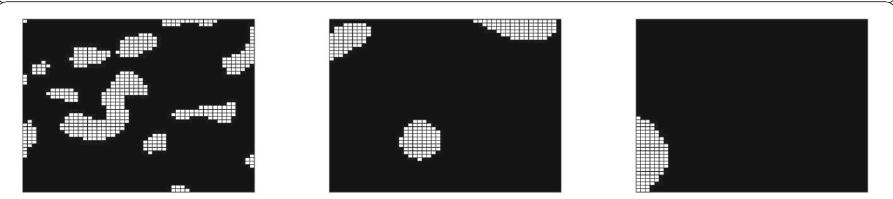
Fig. 17 The PDF of energies in [J]: E e , E d and E h w.r.t. the correlation length (left) (cid:23) c and time steps (right)